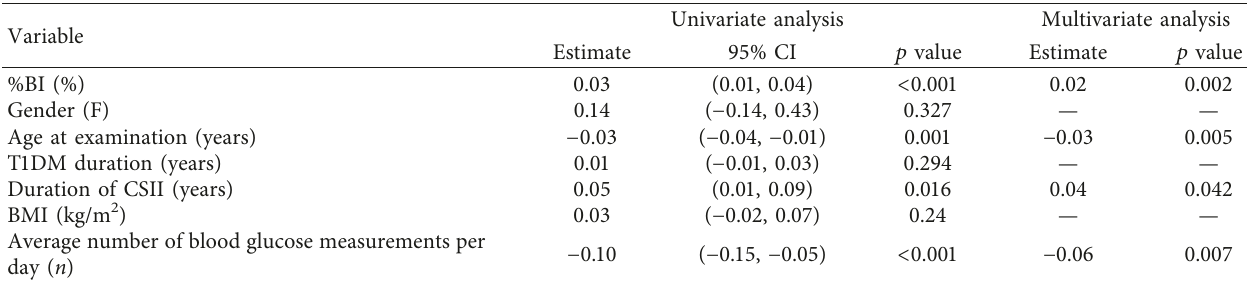
Average number of blood glucose measurements